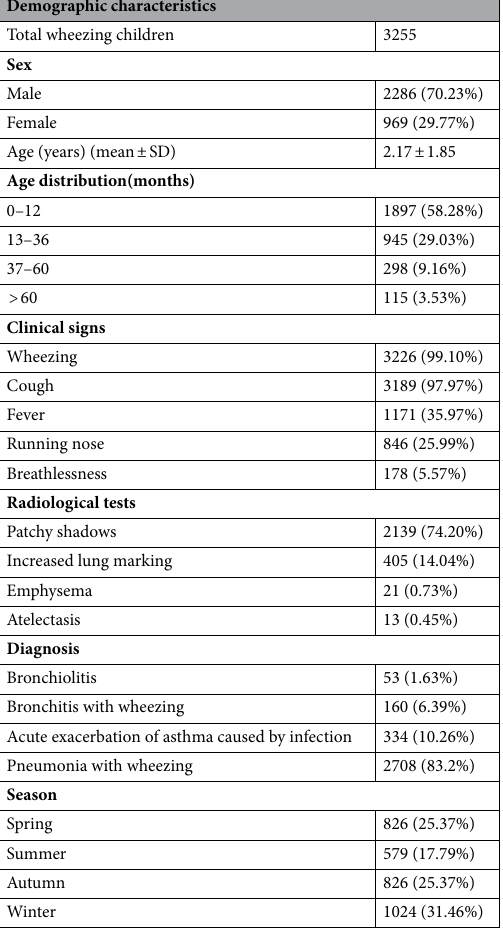
Table 1. Demographic characteristics of children. SD standard